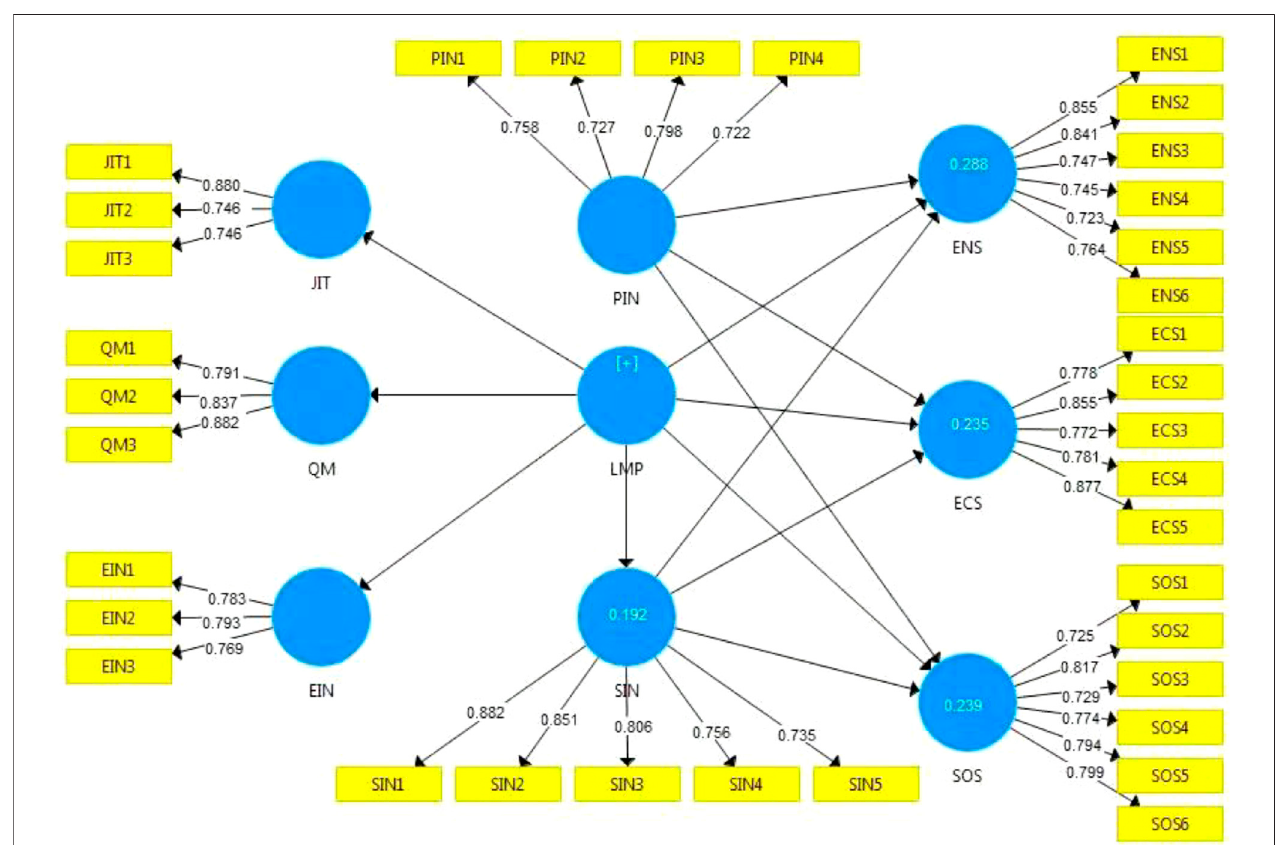
FIGURE 2 | Structural model assessment.